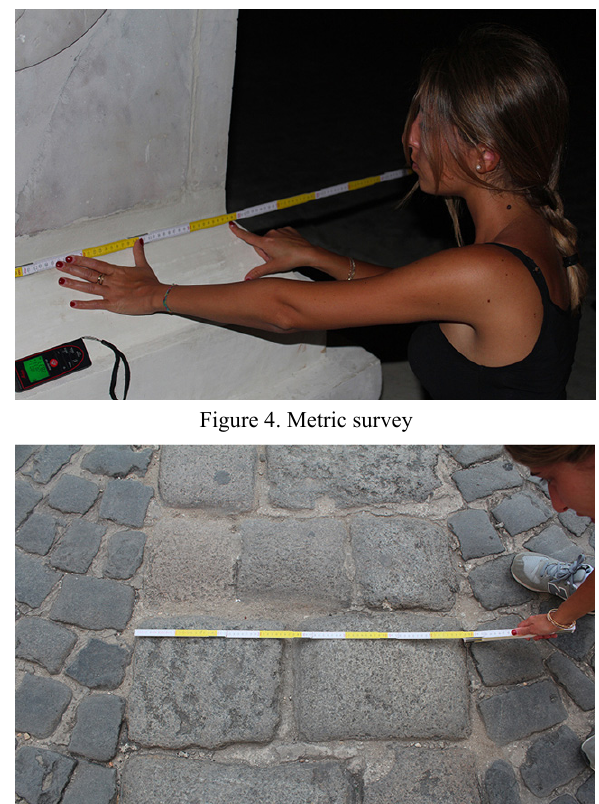
Figure 5. Metric survey